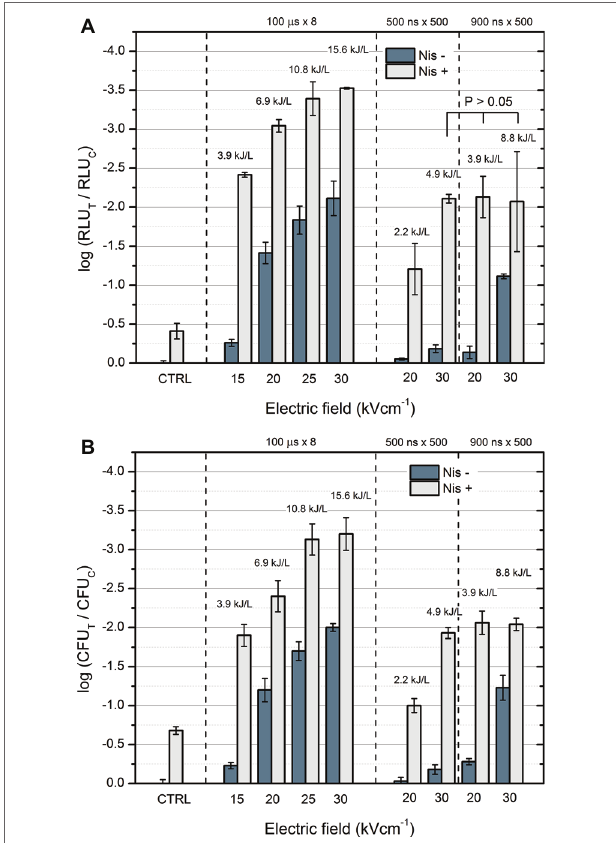
FIGURE 6 | Comparison of the bacteria luminescence and viability assay under different treatment parameters after 2 h incubation with nisin nanoparticles, where (A) bioluminescence assay; (B) viability assay based on CFU count. “Nis − ” corresponds to samples without nisin nanoparticles, and “Nis +” corresponds to samples with 0.2 mg/ml of nisin nanoparticles, RLU T and RLU C and CFU T and CFU C correspond to treated and control samples,